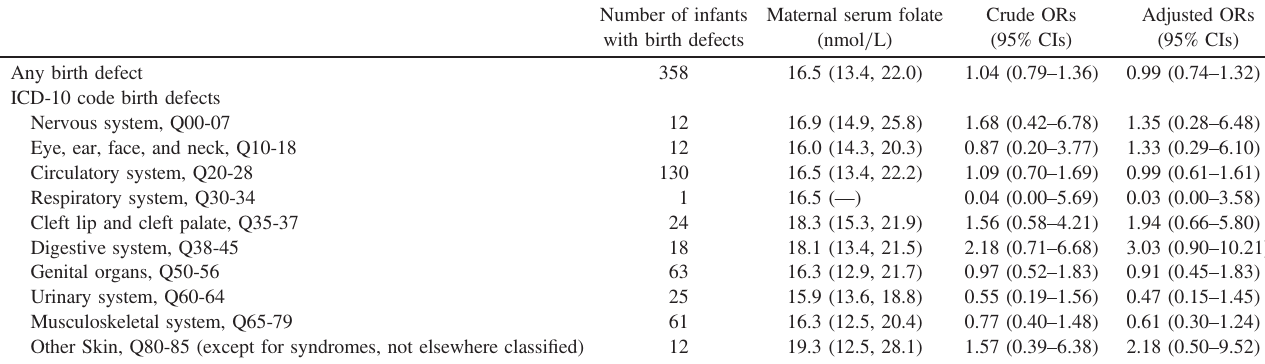
Table 2. Associations between natural log-transformed maternal serum folate concentration during the fi rst trimester and any birth defects and ICD-10 code birth defects after 12 weeks of gestation compared with mothers of infants without birth